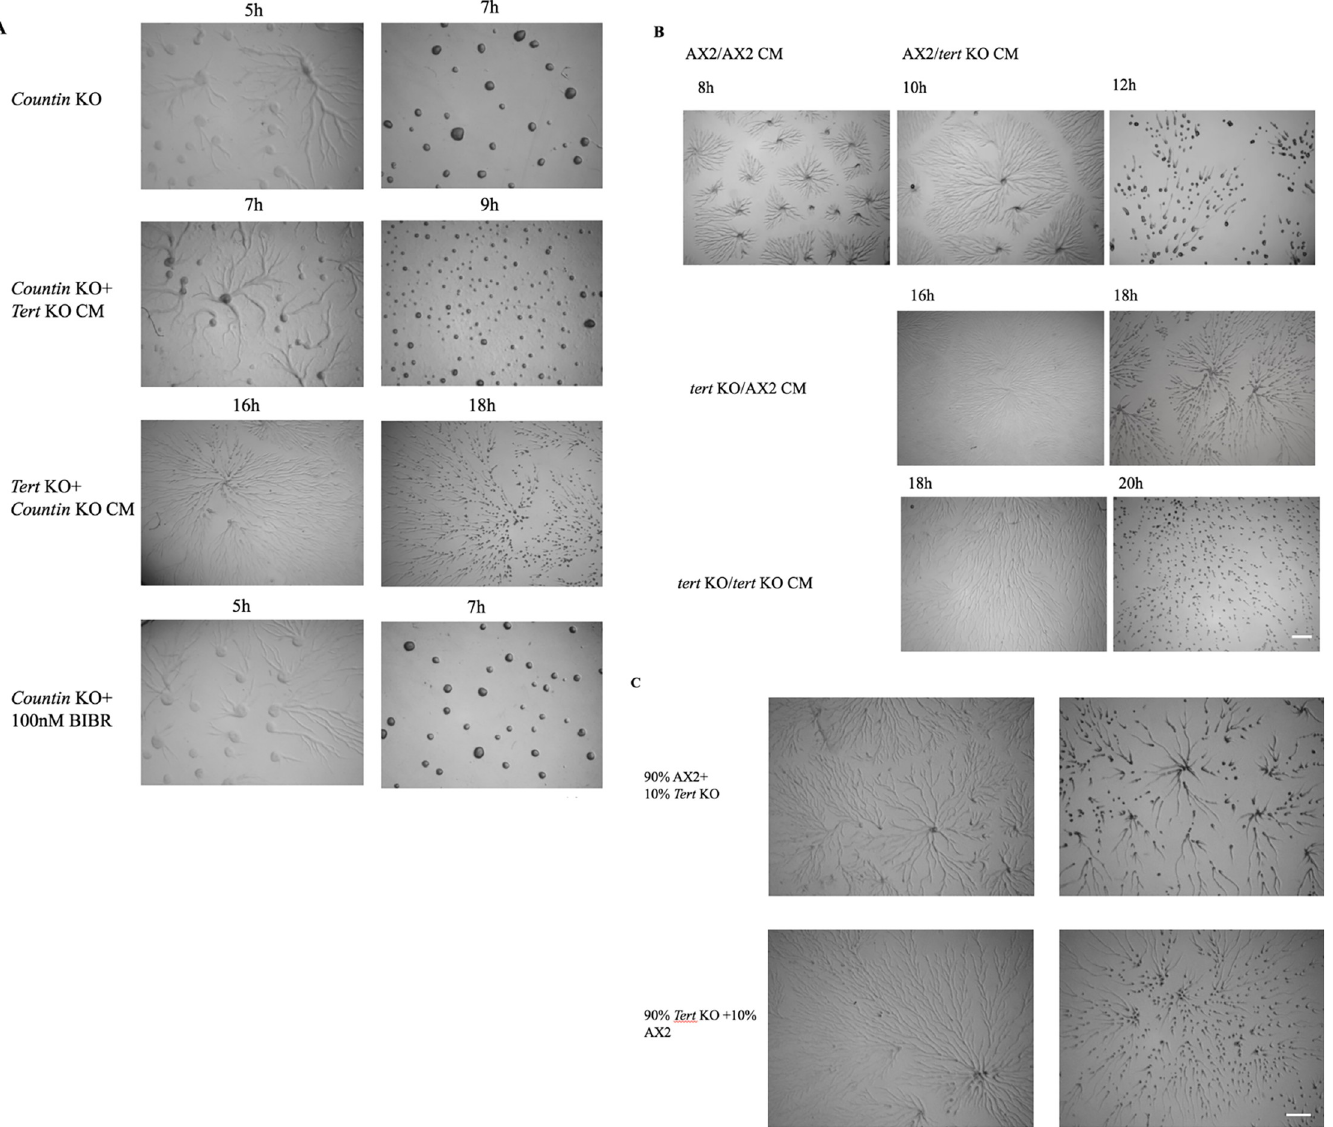
Fig 6. Tert regulates the levels of CF. (A) Countin KO cells were developed on KK 2 agar plates in the presence of tert KO conditioned media or BIBR1532. Scale bar: 0.5 mm; (n = 3). (B) Development in the presence of conditioned medium on KK 2 agar. Tert KO-CM induced stream breaking in AX2. (C) Reconstitution of AX2 in 1:9 ratio with tert KO did not rescue the stream breaking. Scale bar: 0.5 mm; (n =